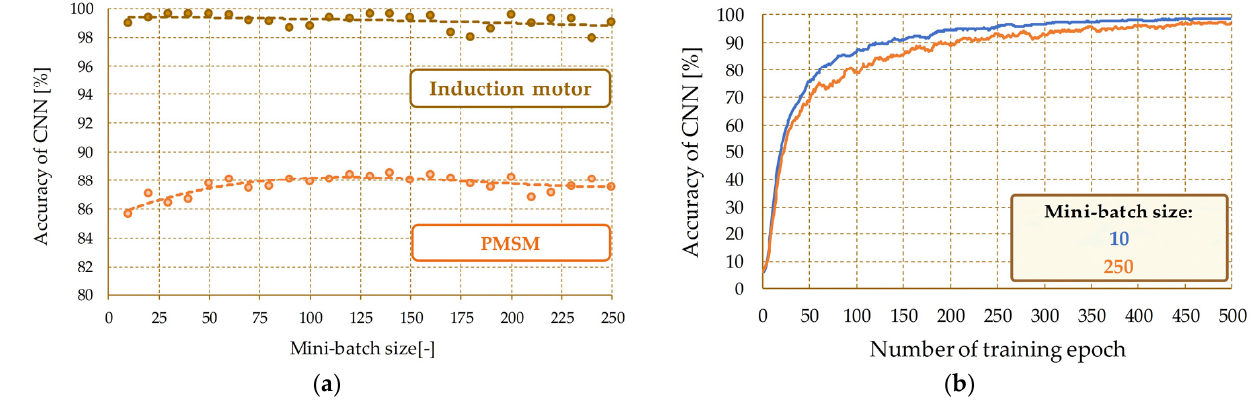
Figure 15. Influence of CNN training process parameters on the precision of the diagnostic system: ( a ) response precision to the elements of the testing package; ( b ) learning curves—induction motor.